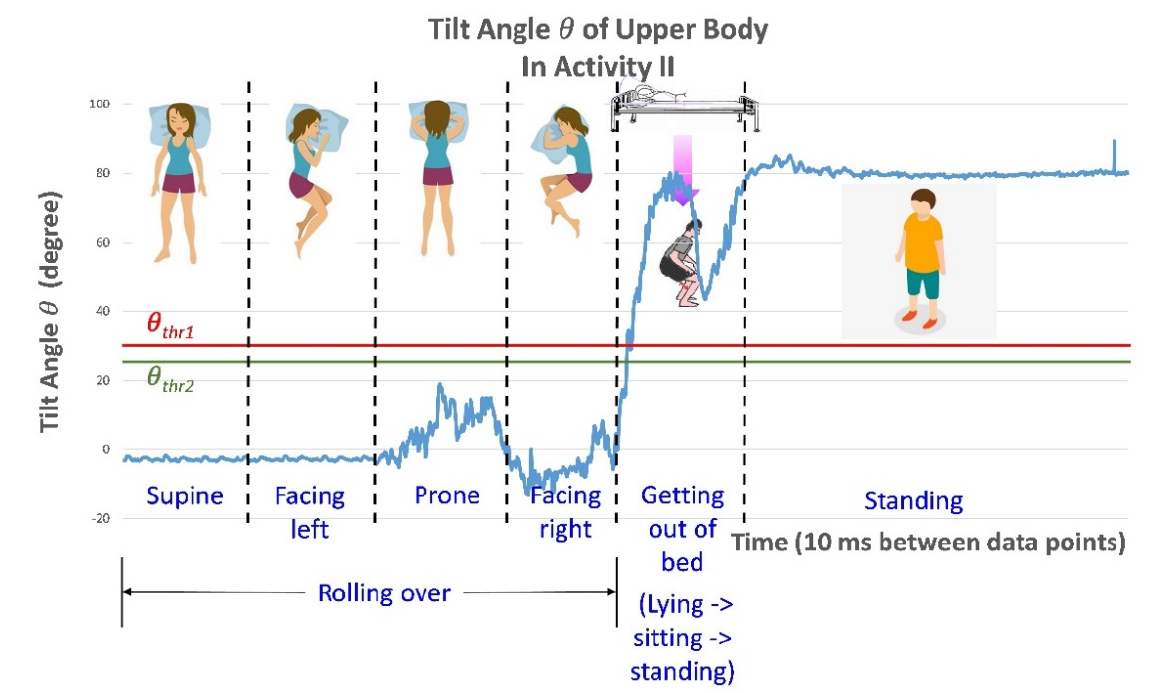
Figure 14. The detected tilt angle 𝜃 in the defined activity pattern, Activity II.